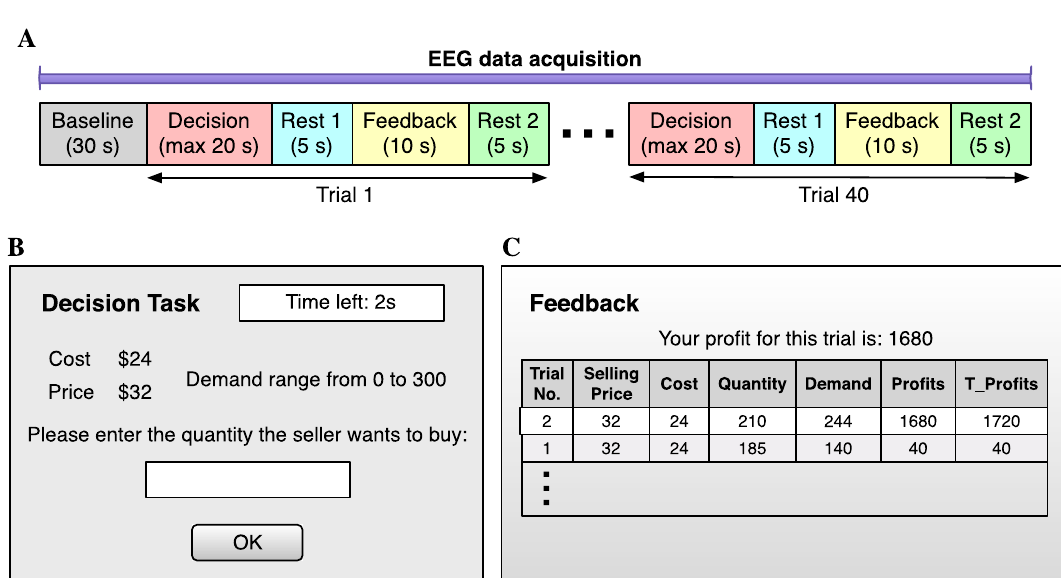
Figure 2. Experimental protocol. ( A ) Diagram of the NP-based experimental protocol. The whole experiment consisted of 30 s of rest (baseline) and 40 consecutive trials. Each trial included a maximum of 20 s of decision, 5 s of the first rest, 10 s of feedback, and 5 s of the second rest. EEG data were recorded throughout the whole experiment. ( B, C ) Computer screens of decision and feedback phases shown to subjects during the NP-based